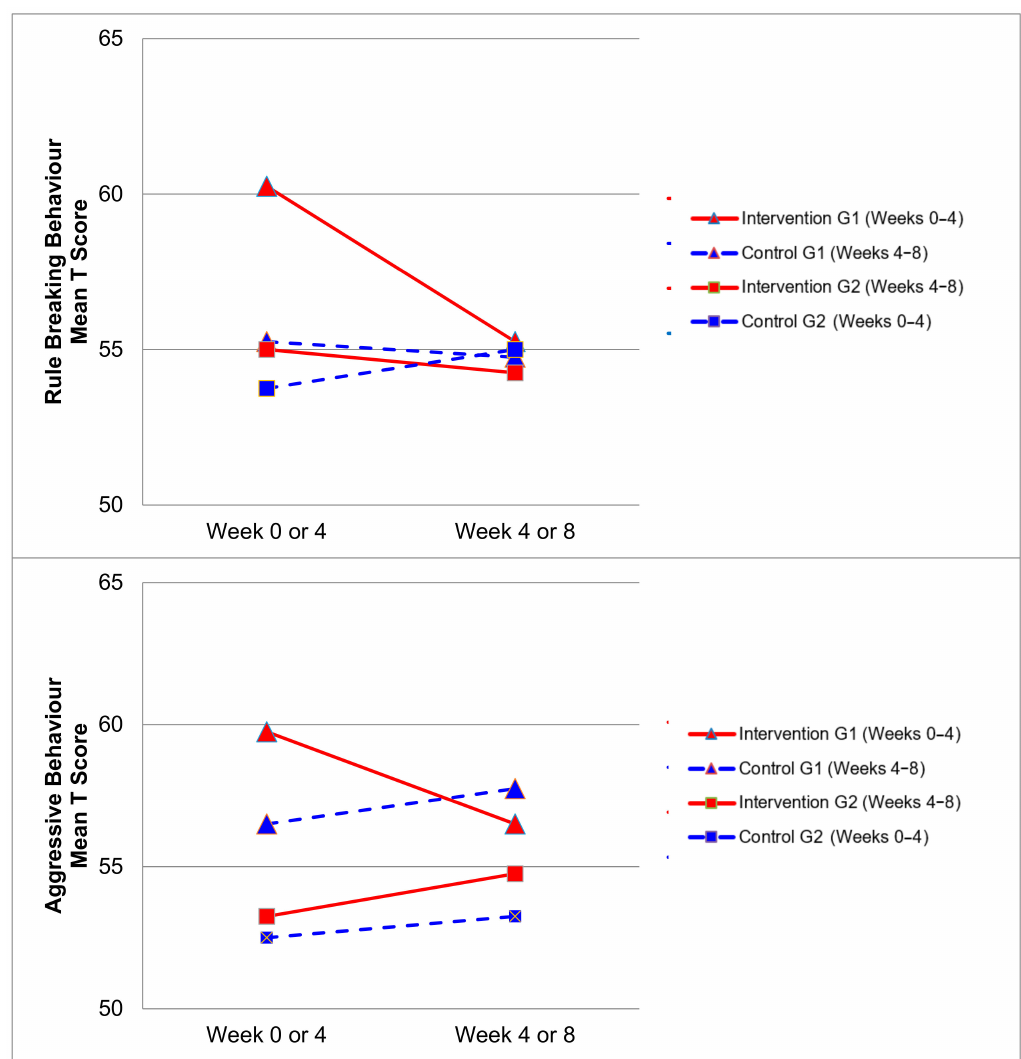
Figure 3. Mean t score changes within Group 1 (G1) and Group 2 (G2) based on intervention vs. control periods for rule breaking behaviour and aggressive behaviour